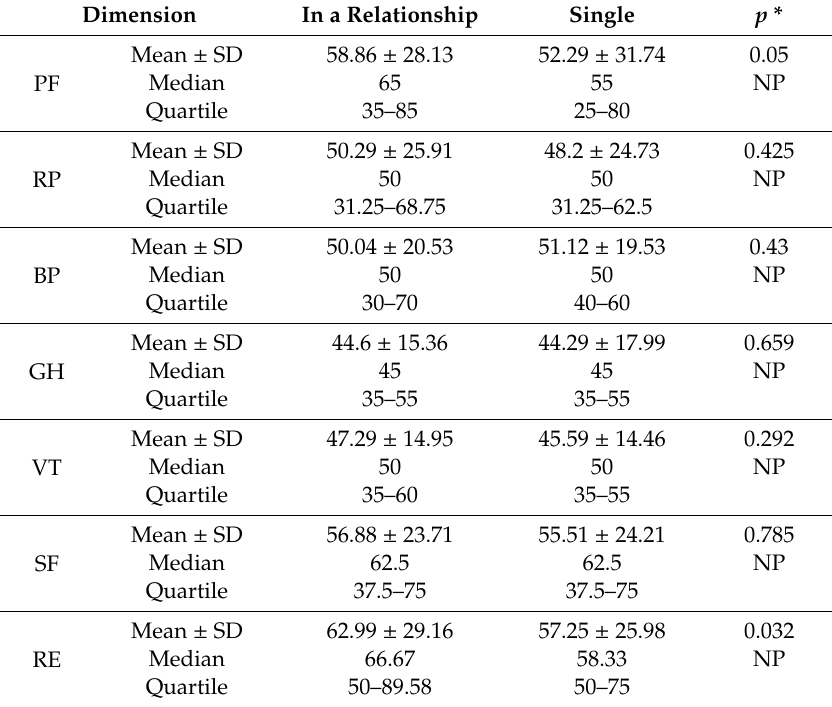
Table 7. Quality of life in individual dimensions versus marital status of